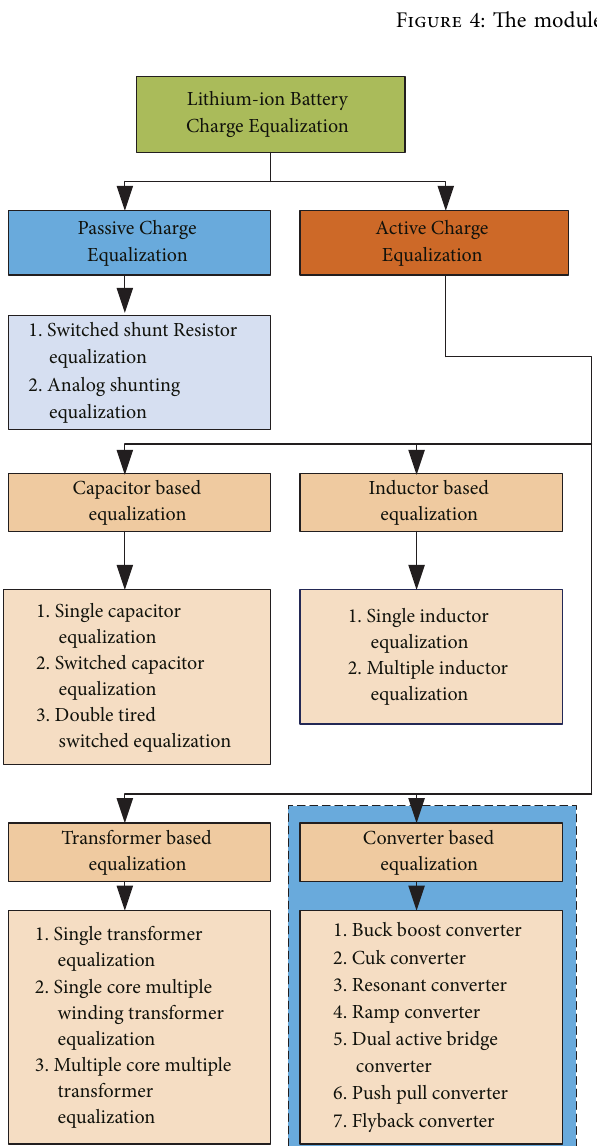
Figure 5: Classifcation of BEC